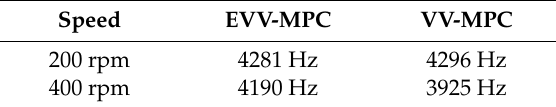
Table 2. Switching frequency in pre-fault